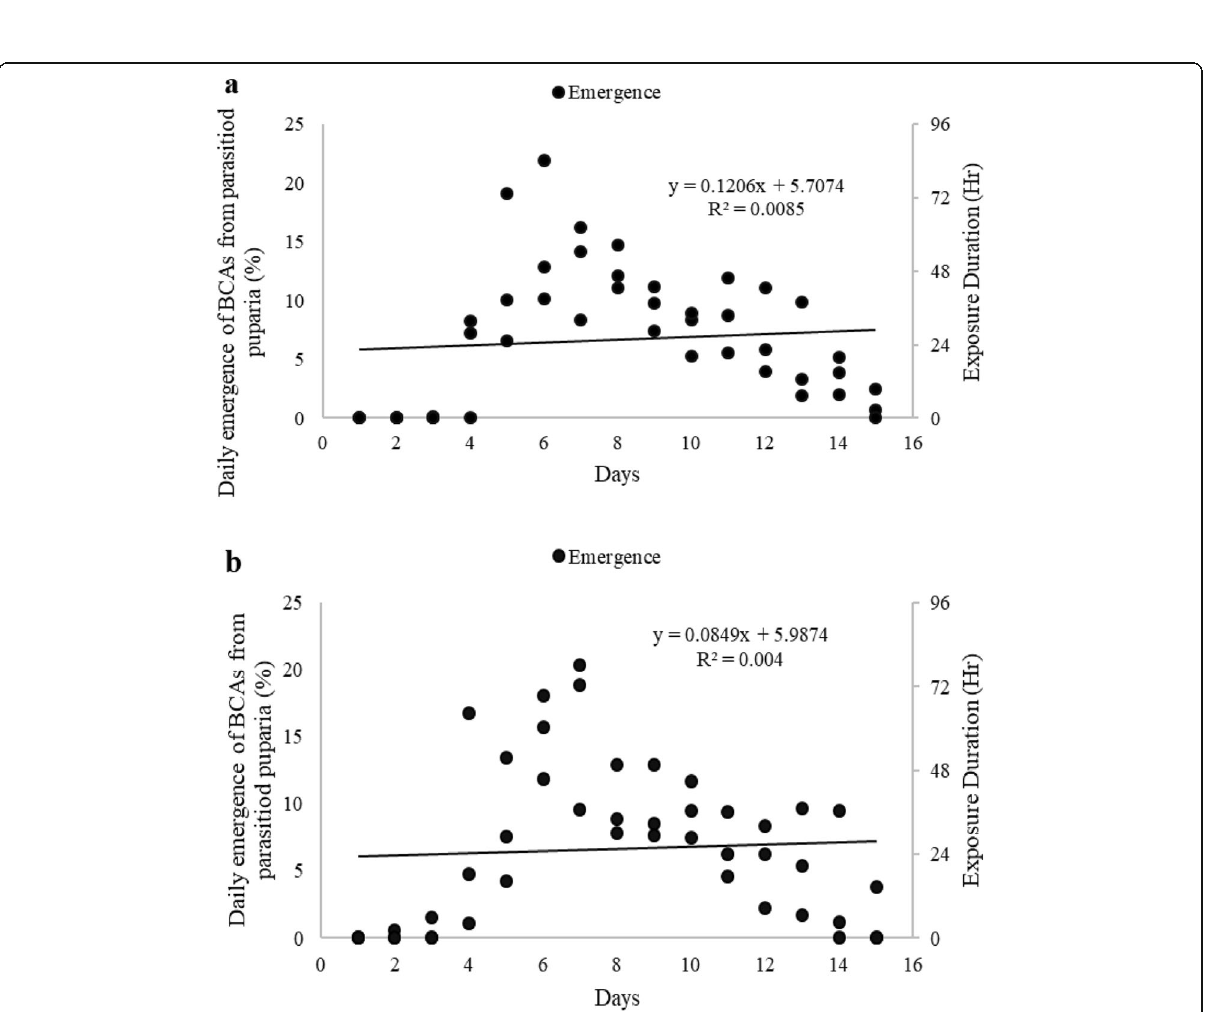
Fig. 4 Correlation between adult emergence of Dirhinus giffardii and exposure duration a Zeugodacus cucurbitae and b Bactrocera dorsalis